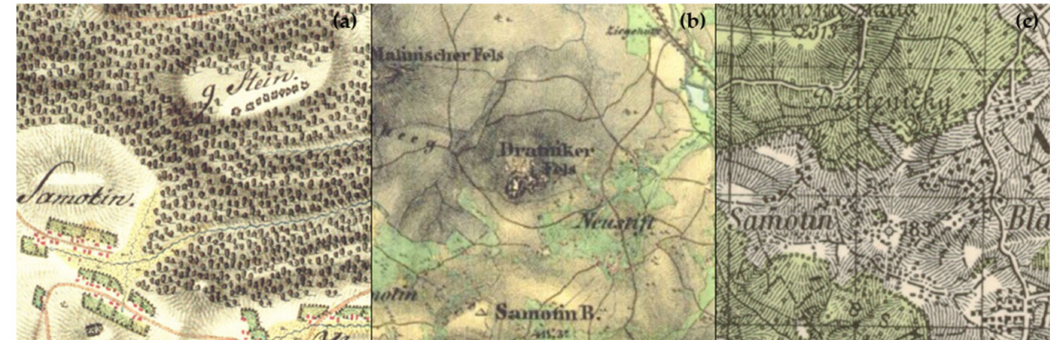
Figure 5. Dr á tenick á sk á la and its surroundings on the maps ( a ) of the 1st (1764–1768), ( b ) of the 2nd (1836–1852), ( c ) and of the 3rd (1876–1878) military mappings [70–73].